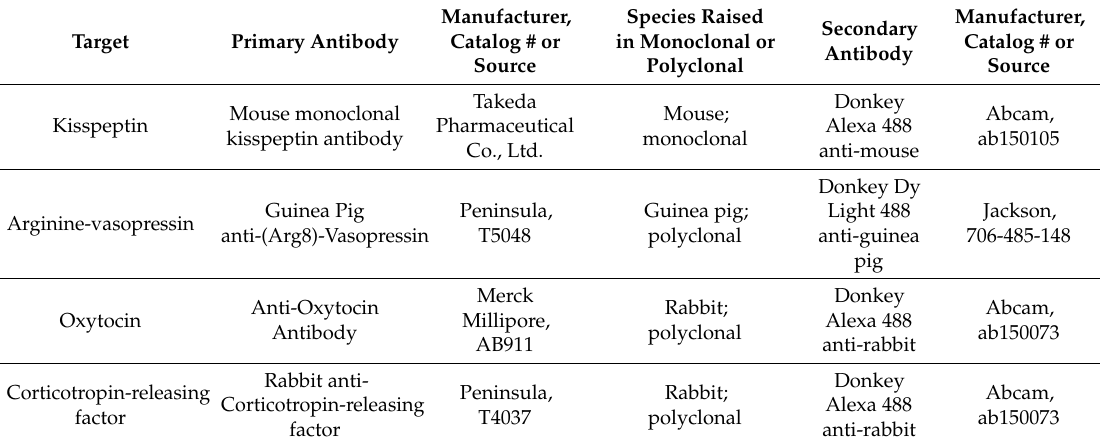
Table 1. Primary and secondary antibodies